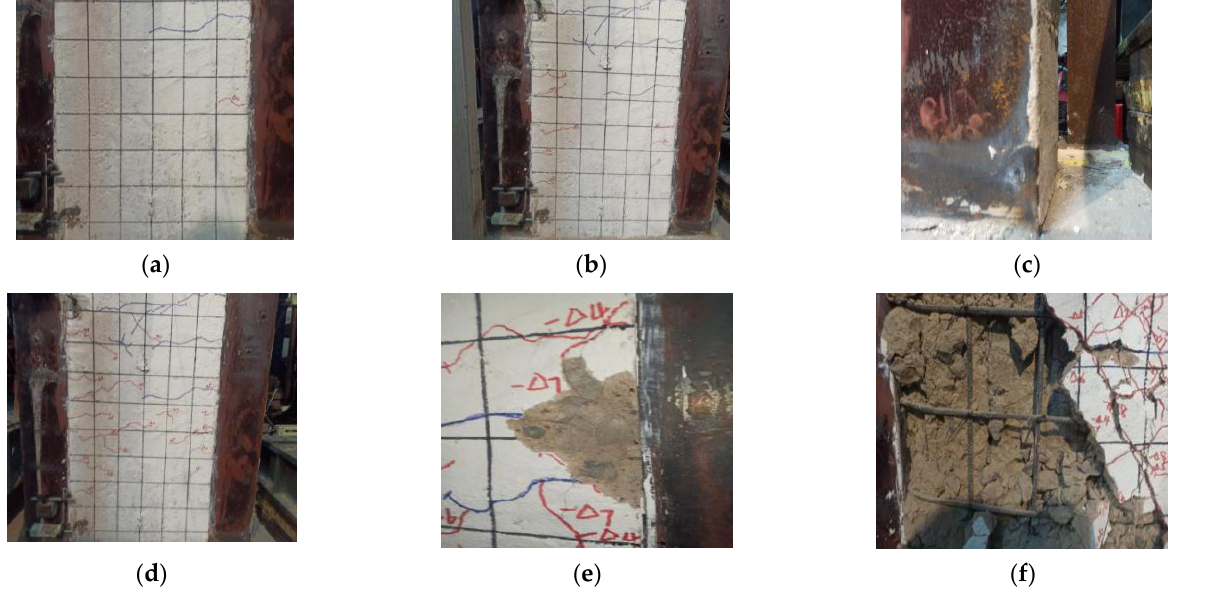
Figure 14. Failure processes and modes of specimen SW2. ( a ) Displacement angle 1/800; ( b ) Displacement angle 1/500; ( c ) Displacement angle 1/300; ( d ) Displacement angle 1/200; ( e ) Displacement angle 1/50; ( f ) Displacement angle 1/30.